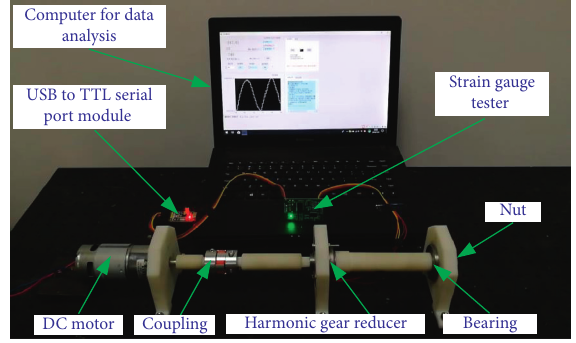
Figure 9: Experimental platform for deformation characteristics of the flexspline in harmonic gear reducer.